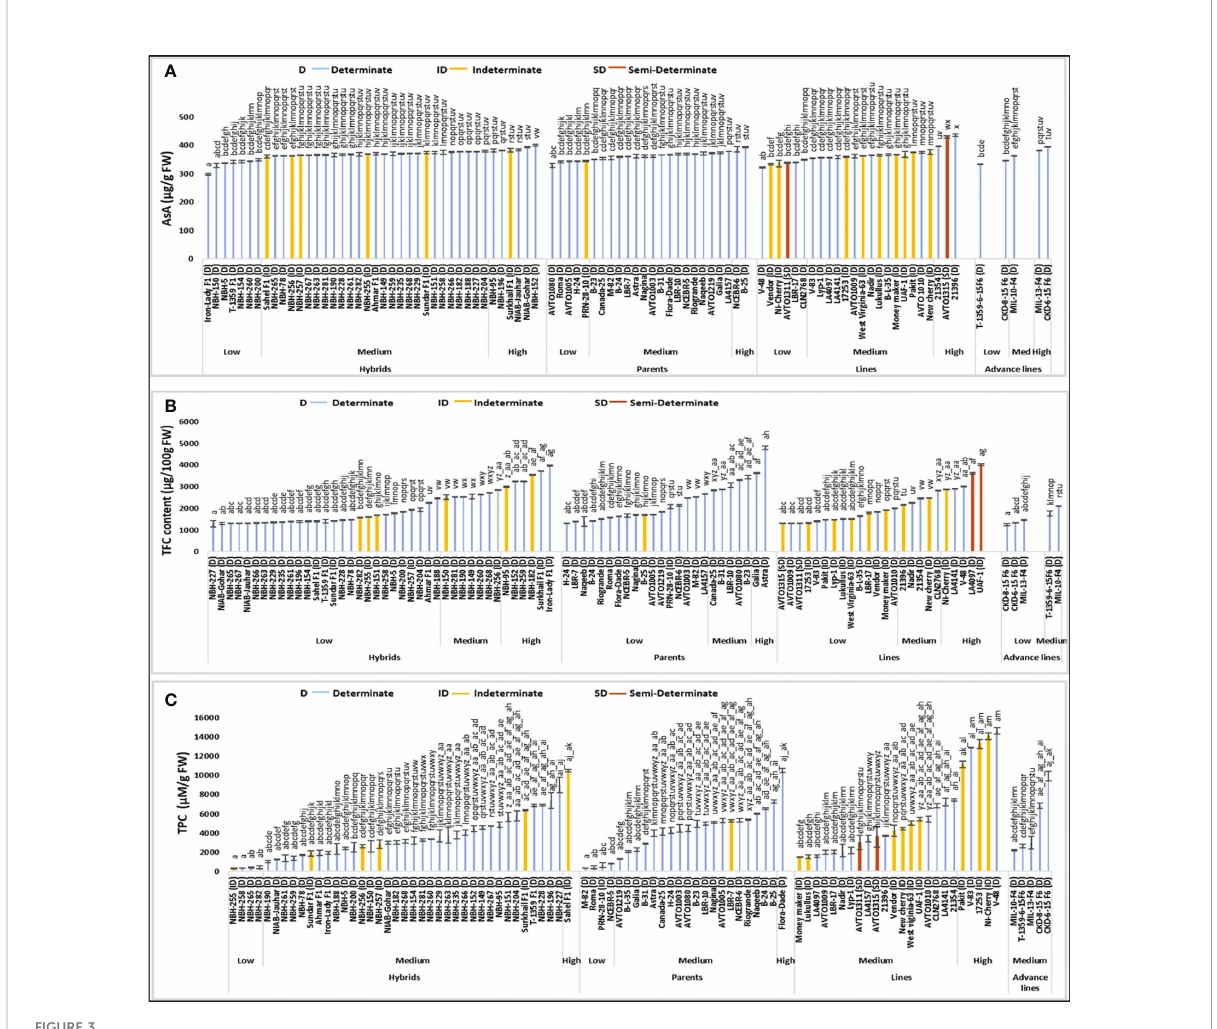
FIGURE 3 Comparison of fruit ascorbic acid (AsA) (A) , total fl avonoid content (TFC) (B) and total phenolic compounds (TPC) (C) in different tomato genotypes (mean value ± SD). Mean value with varying alphabet differs signi fi cantly (p < 0.05, Tukey ’ s